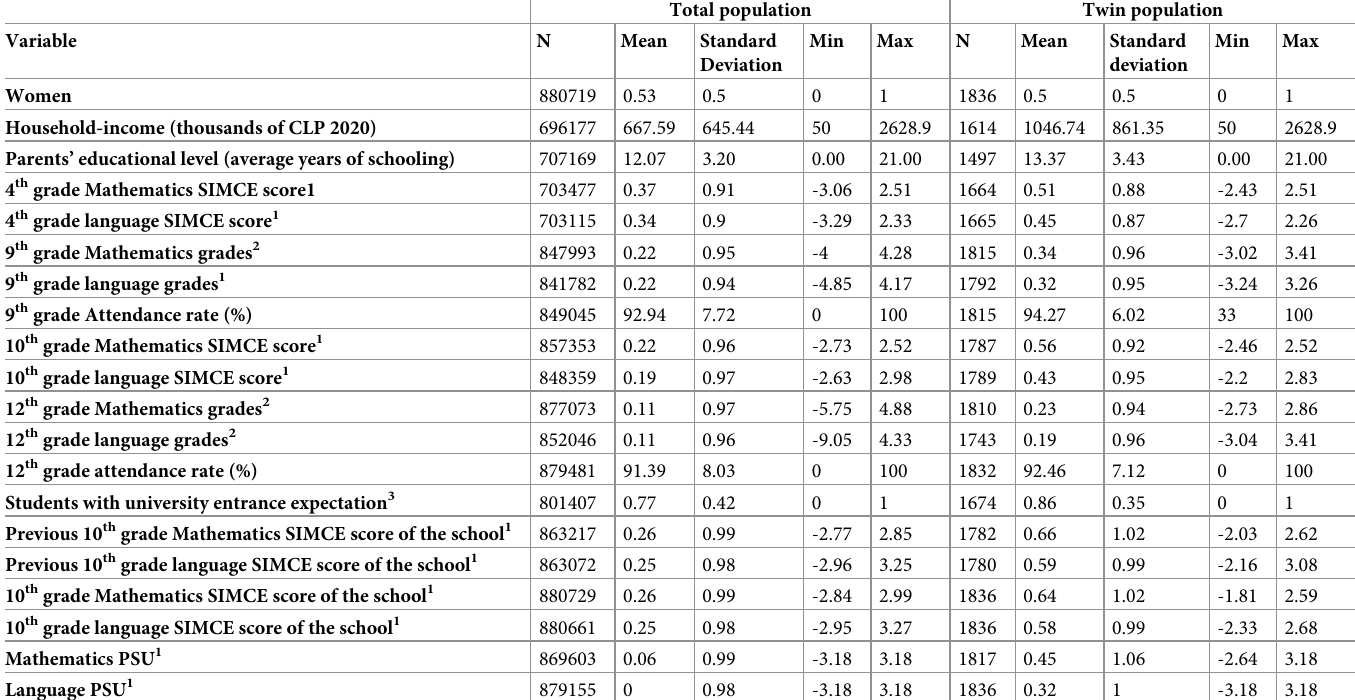
Table 3. Descriptive statistics of the student population, total population and twins population, 2015–2020